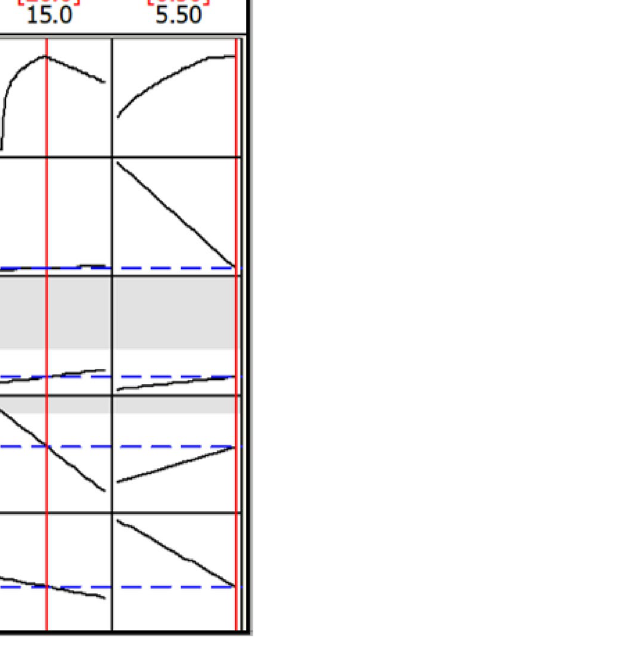
Figure 2. 2 3 full factorial design (FFD) optimization